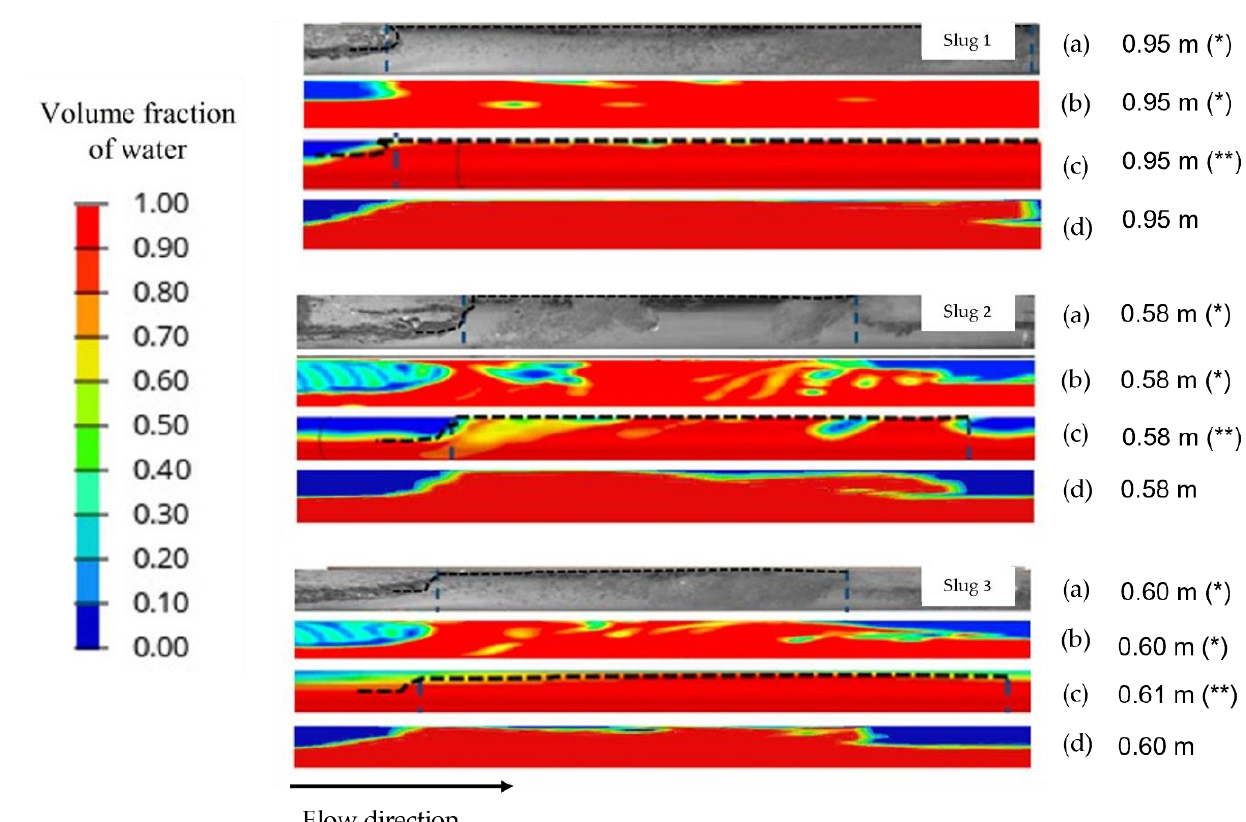
Figure 6. Comparison on slug flow morphology between ( a ) experimental result [17], ( b ) Ansys ® simulation [10], ( c ) STAR-CCM+ simulation [23] and ( d ) Altair ® AcuSolve™ simulation. Note that the slug body length values marked with * and ** were extracted from Ref. [10], respectively.